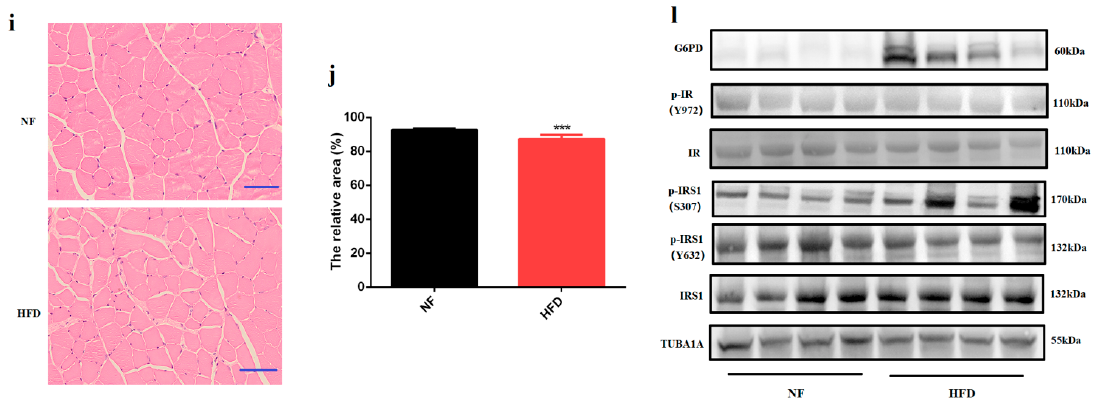
Figure 5. G6PD is involved in impaired insulin signaling activation caused by HFD treatment.